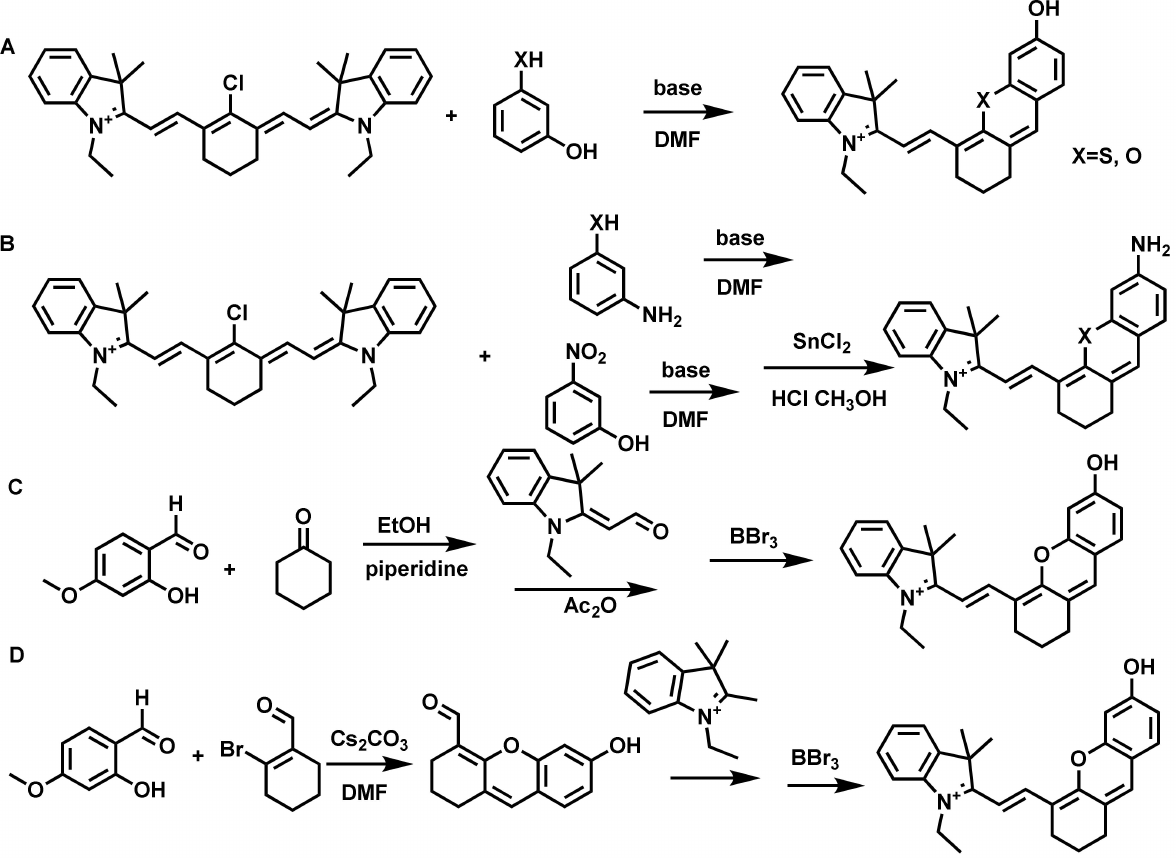
Figure 1. Synthetic method for preparing a hemicyanine scaffold. ( A ) Synthesis of hydroxylated hemicyanine scaffold. ( B ) Synthesis of amine-based hemicyanine scaffold. ( C ) Synthesis of improved hemicyanine scaffold. ( D ) Synthesis of the simplest hemicyanine